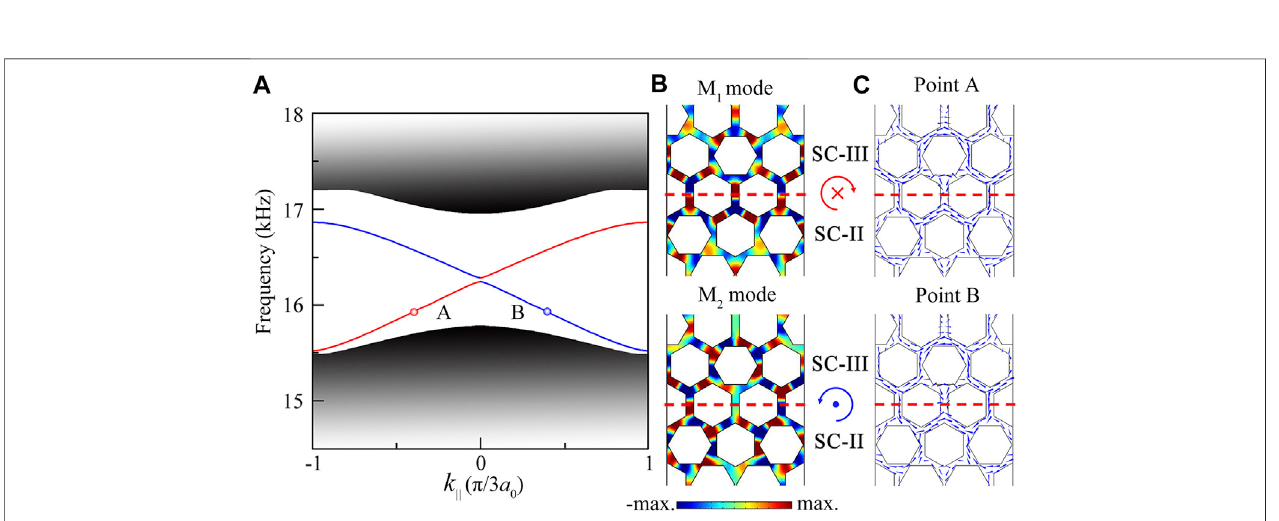
FIGURE 3 | (A) Dispersion relations of the ATI composed of the SC-II and SC-III. (B) Simulated pressure eigenfunctions (M 1 and M 2 modes) of the supercell at the point A ( k || (cid:1) − 0.4). (C) Simulated acoustic energy fl ow of the pseudospin-dependent edge states at the points A and B ( k || (cid:1) 0.4). Red dashed lines refer to the domain wall of the ATI.